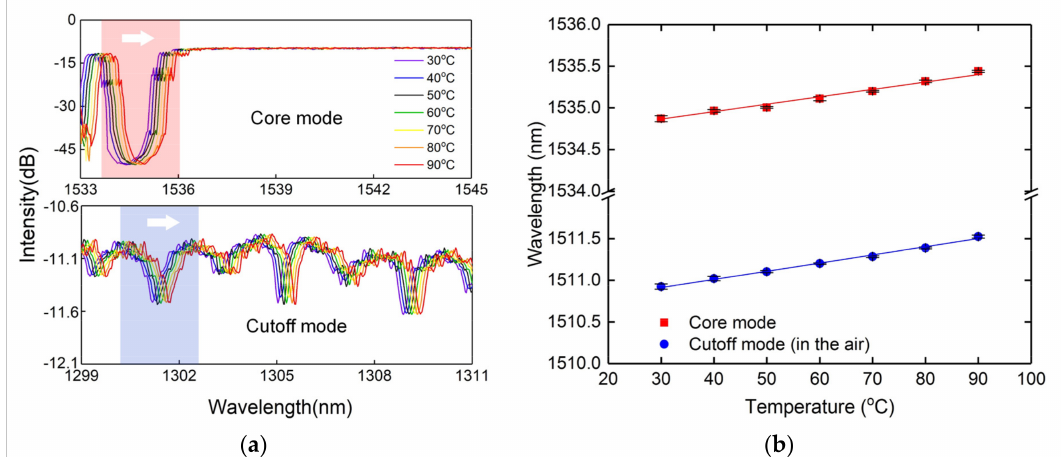
Figure 10. ( a ) Spectral responses to temperature of the core mode and cuto ff mode; ( b ) Temperature sensitivities of the core mode and cuto ff